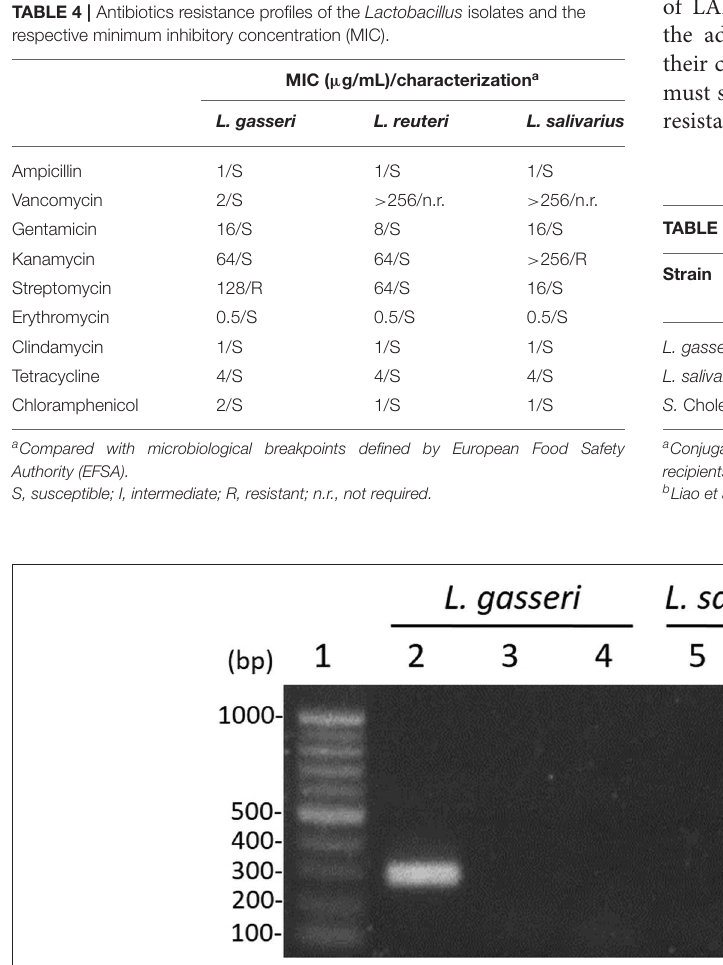
FIGURE 6 | Detection of antibiotic-resistance genes in Lactobacillus strains by PCR. Identification of streptomycin (lanes 2–4) and kanamycin (lanes 5 and 6) determinants in L. gasseri and L. salivarius , respectively. Lane 1, 100-bp DNA ladder; representative L. gasseri culture containing aadA (lane 2), aadE (lane 3), and ant(6) (lane 4); representative L. salivarius containing aph(3 ′′ )-III (lane 5); ant(2 ′′ )-I (lane 6).